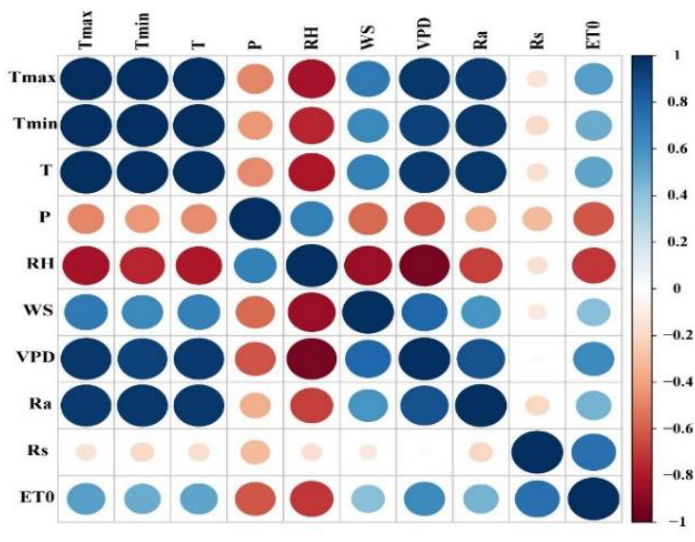
Figure 3. Correlation analysis of meteorological factors.